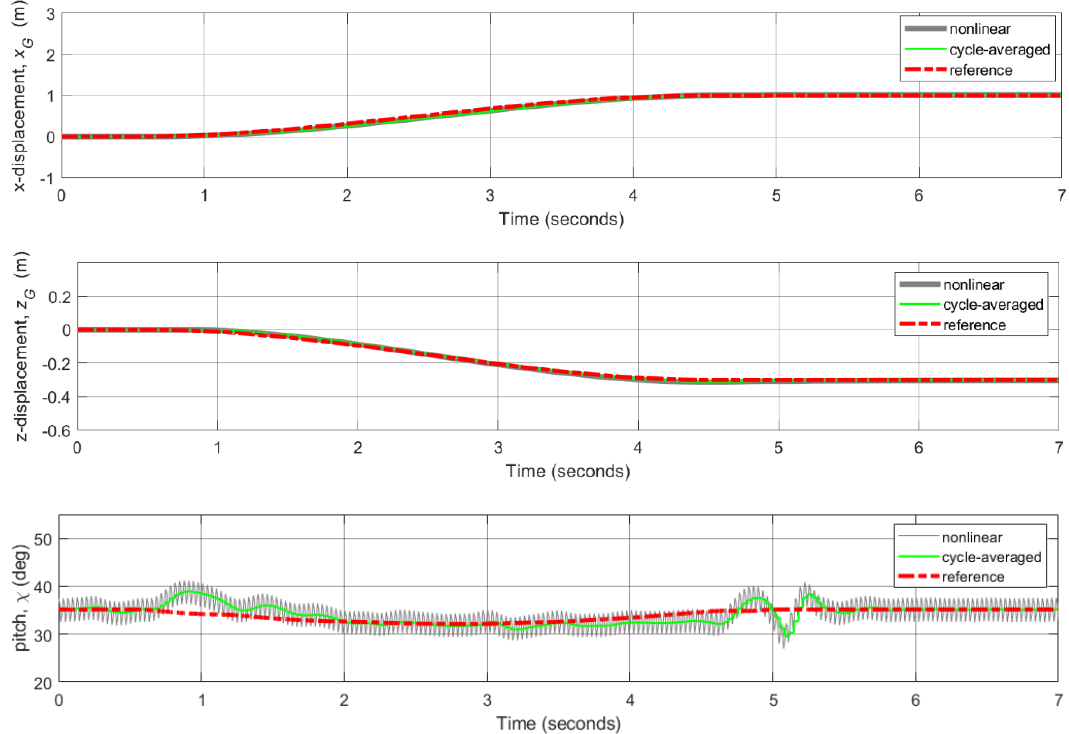
Figure 23. Flight control simulations for trajectories tracking control of nonlinear FWMAV model (case 1).